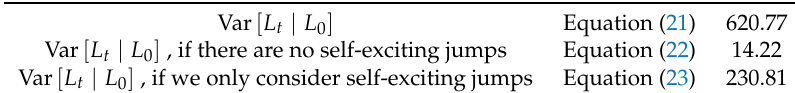
Table 2. The variance of loss: Var [ L t | L 0 ]